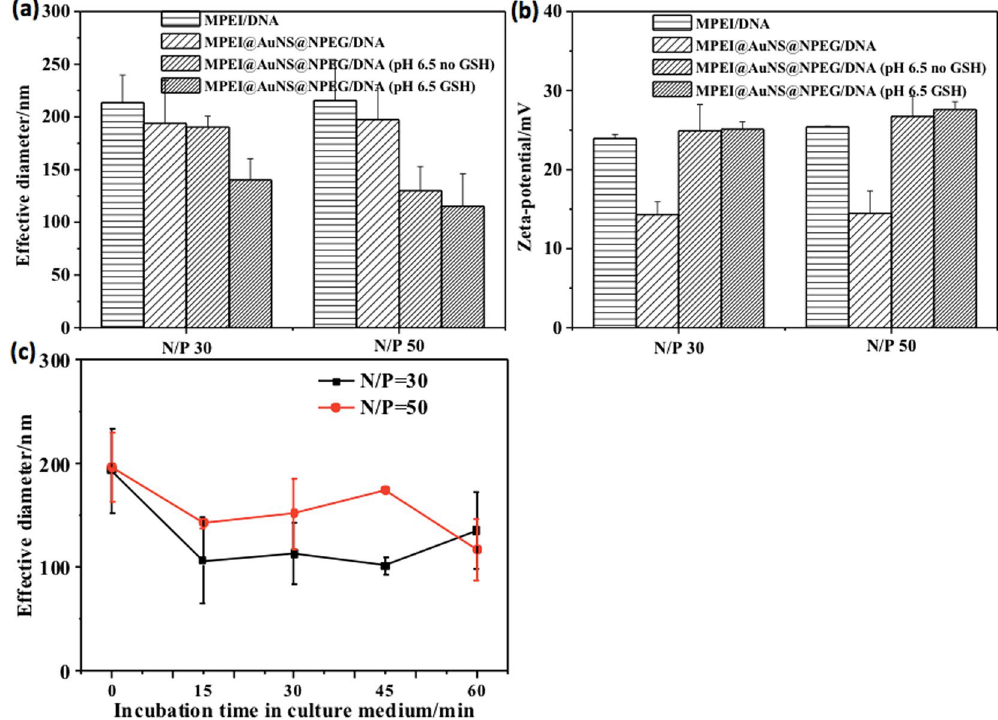
Figure 5. ( a ) Effective diameters and ( b ) zeta-potentials of the polyplexes at different N/P ratios; ( c ) Time- dependent diameters of MPEI@AuNS@NPEG/DNA polyplexes at N/P ratios of 30 and 50 in culture medium. (Error bar stood for